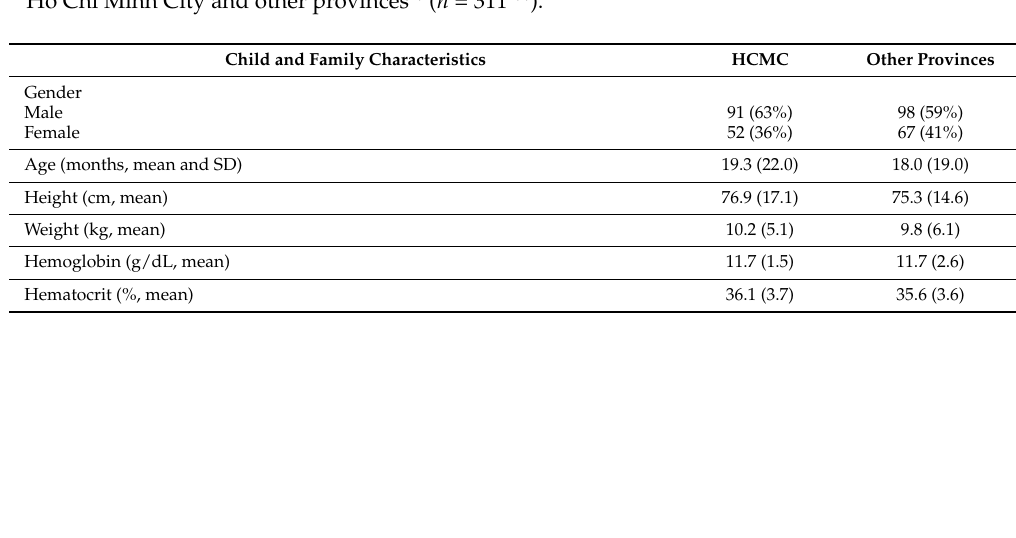
Table 1. Characteristics of participating children and their families, comparing children from Ho Chi Minh City and other provinces * ( n = 311 **).